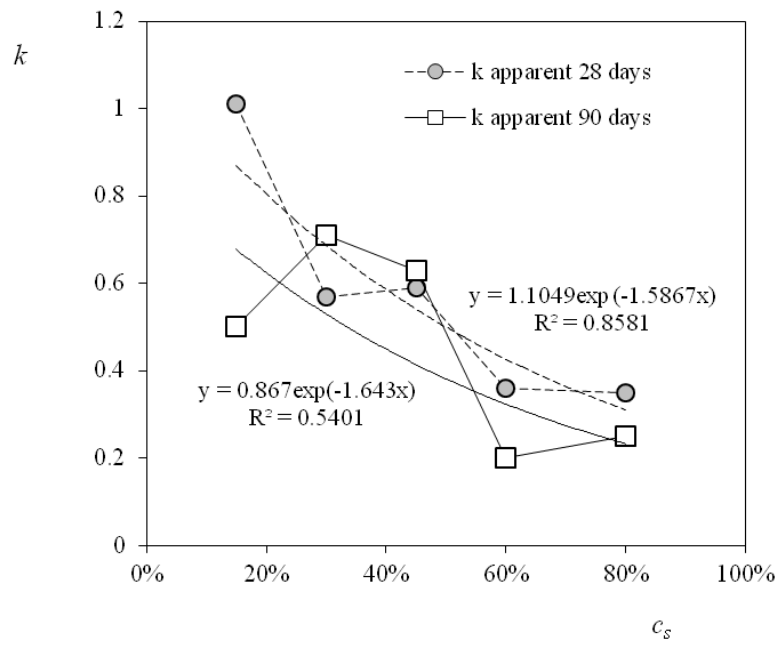
Figure 9. Evolution of the value of ‘ k apparent’ depending on the amount of glass powder con- tained in the binder ( Gp ).